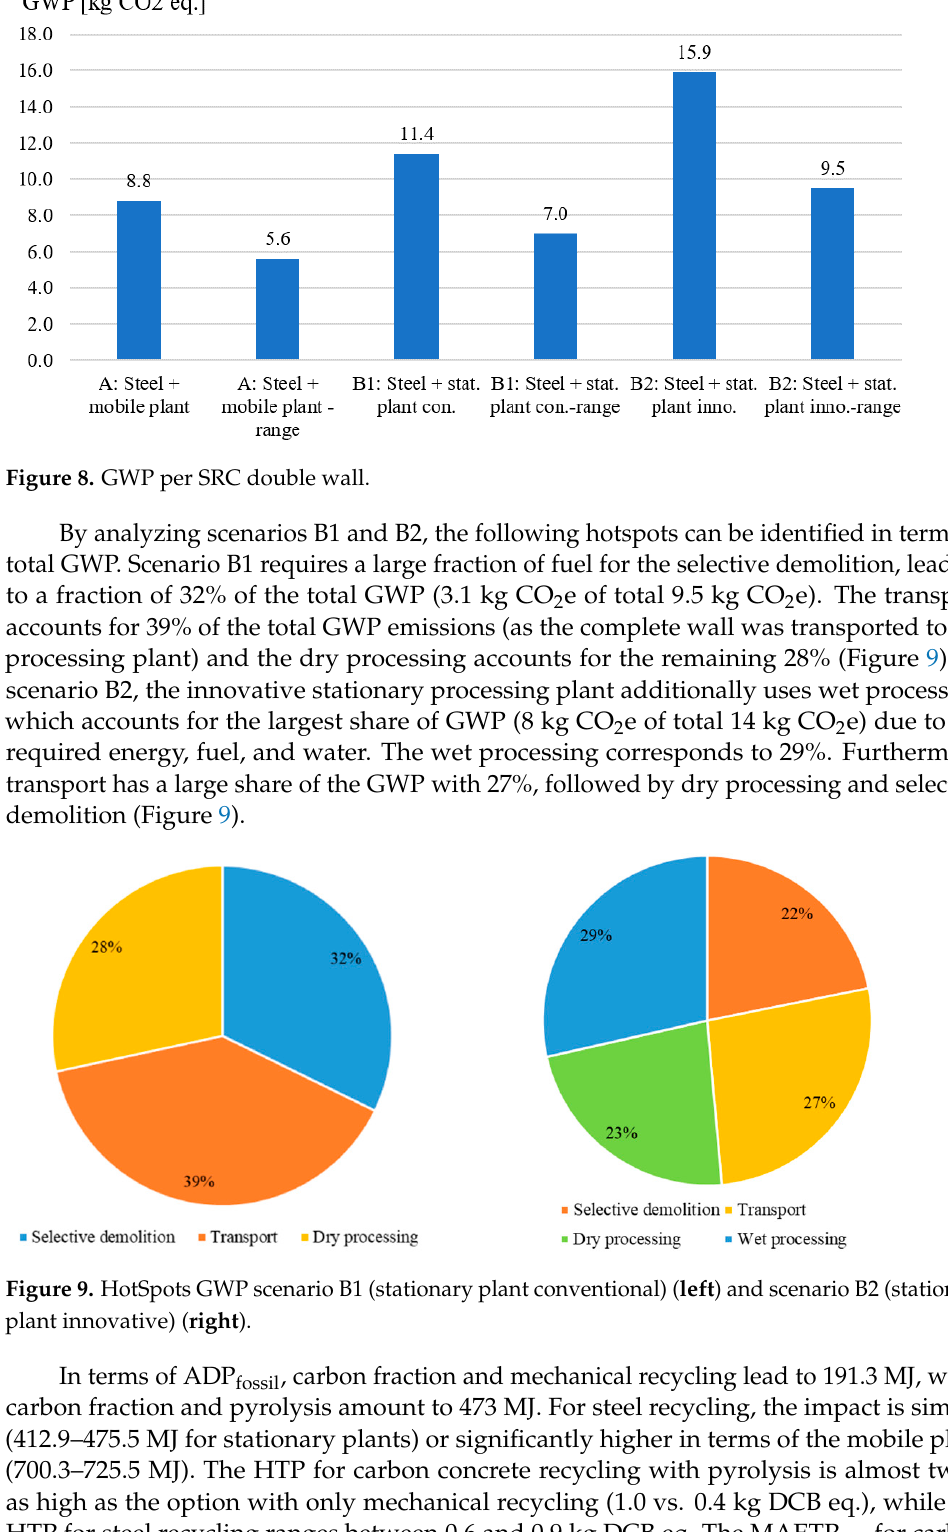
Figure 8. GWP per SRC double wall.